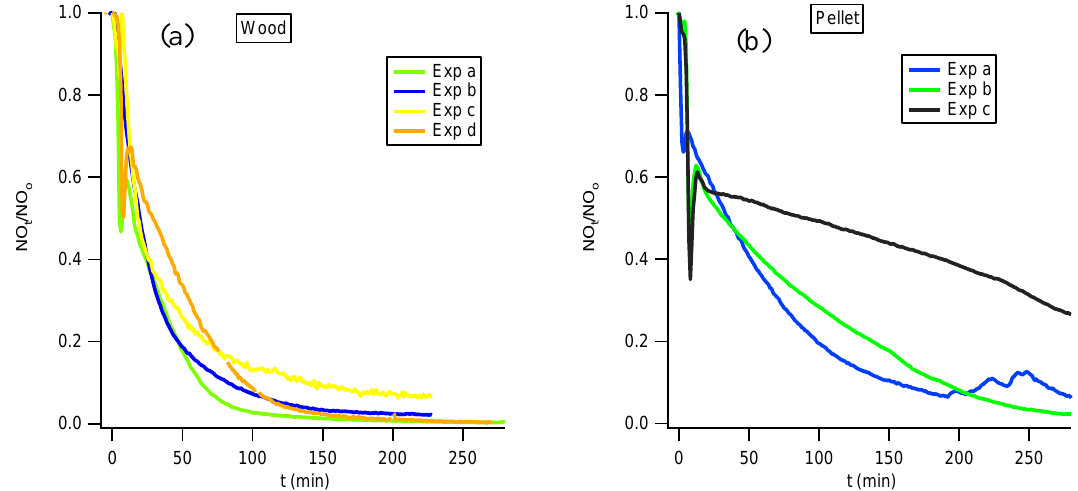
Figure 6. NO consumption as a function of UV irradiation time for ( a ) wood and ( b ) pellet experiments. NO concentration is normalized to the initial concentration.